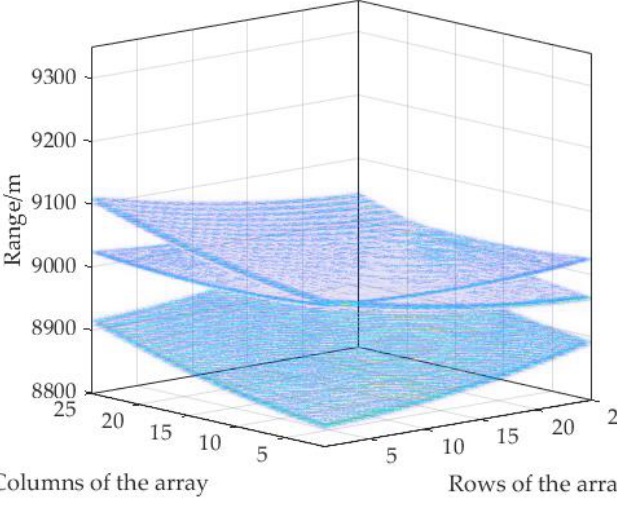
Figure 10. The range profile in 3D space.